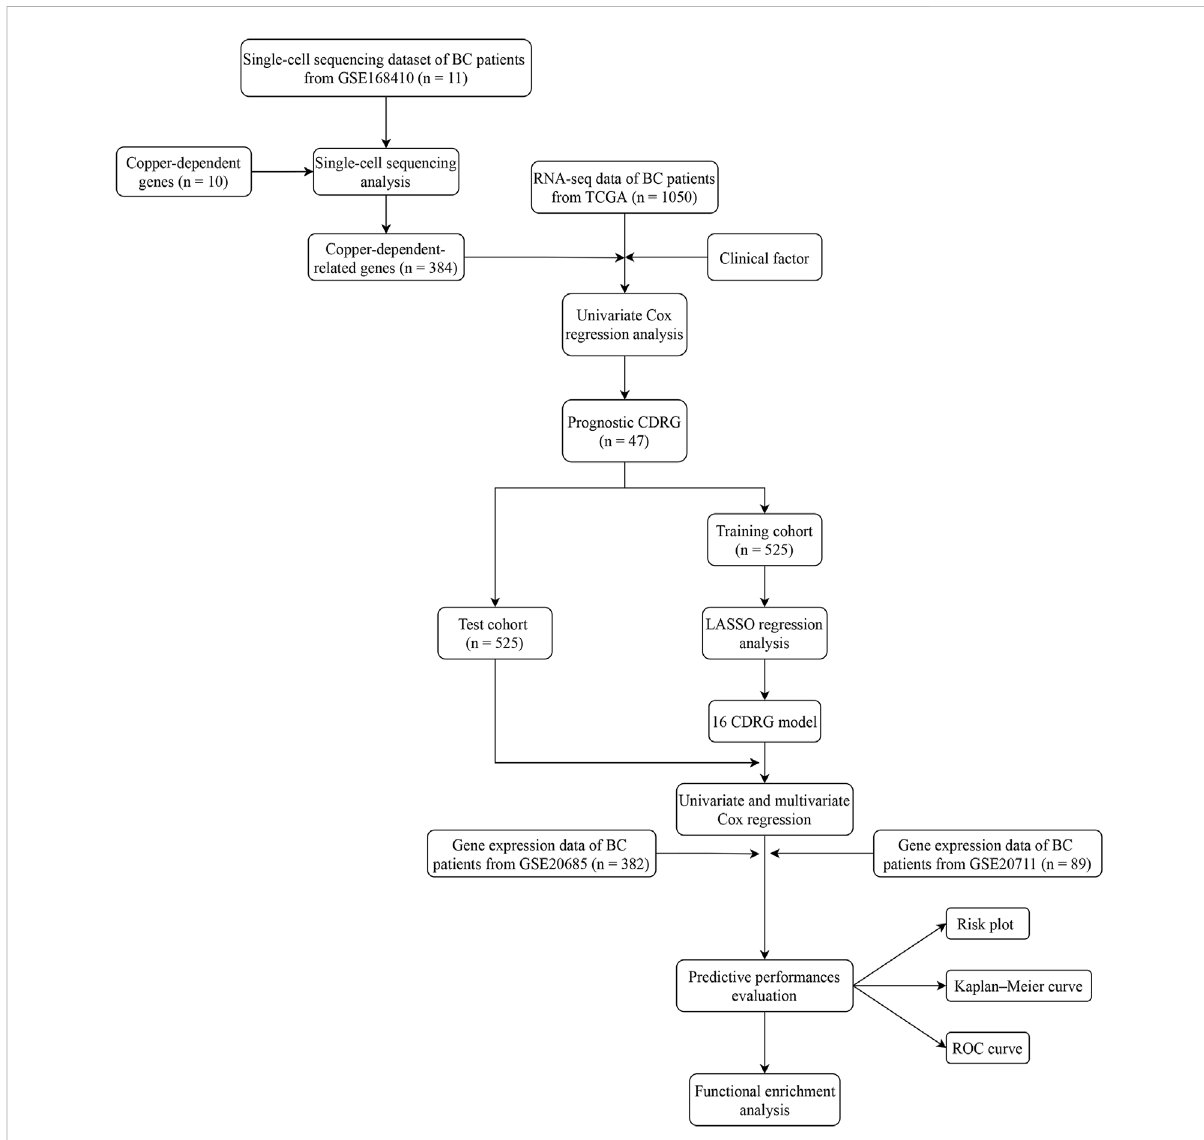
FIGURE 1 The fl ow chart of data collection and analysis in this